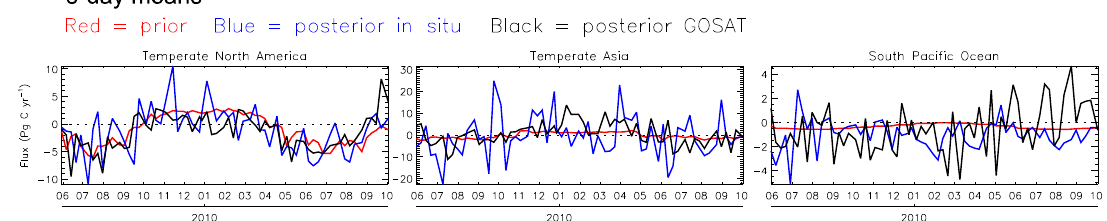
Figure 5. Prior, posterior in situ only, and posterior GOSAT only 8-day mean NEP ( ×− 1) and ocean fluxes, aggregated over selected TransCom regions. Note that vertical scales are different in each of the